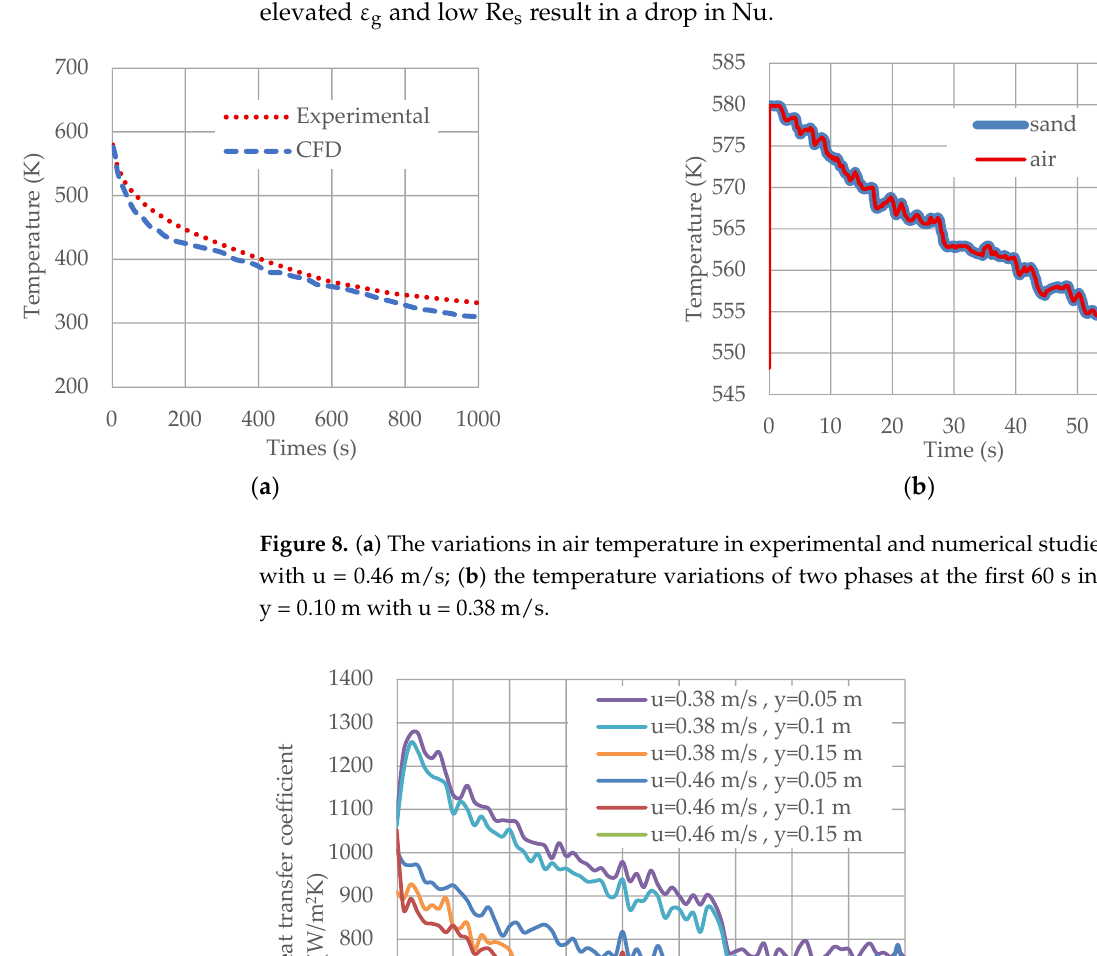
( b ) Figure 7. ( a ) Variation of the air temperature in the experimental study at different elevations with u = 0.46 m/s; ( b ) variations in the air temperature of an FB containing sand and CARBOHSP particles at y = 0.10 m with u = 0.38 m/s. The thermal experiment was repeated using CARBOHSP particles to see the differ- ence, if any, between them and sand particles. As seen in Figure 7b, when CARBOHSP particles are used instead of sand, the air temperature becomes somewhat cooler at the same surface velocity. However, in general, the cooling trends for sand and the CAR- BOHSP particles are identical. The air temperature changes with time in the experiment and the simulation under the same operating conditions are shown in Figure 8a. The temperature variations correspond